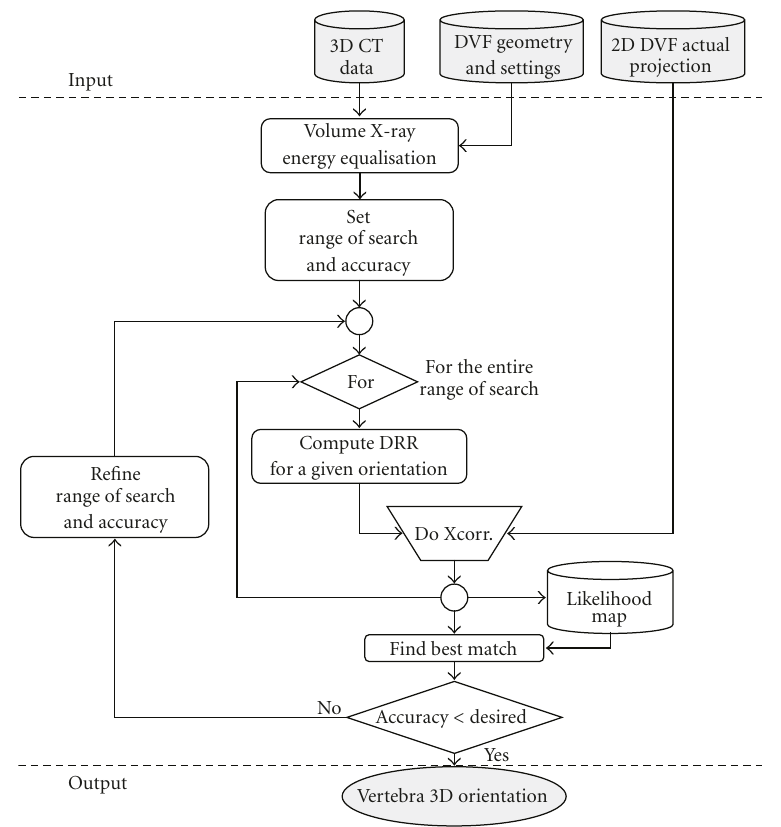
Figure 4: Flow-chart of the 2D-3D registration